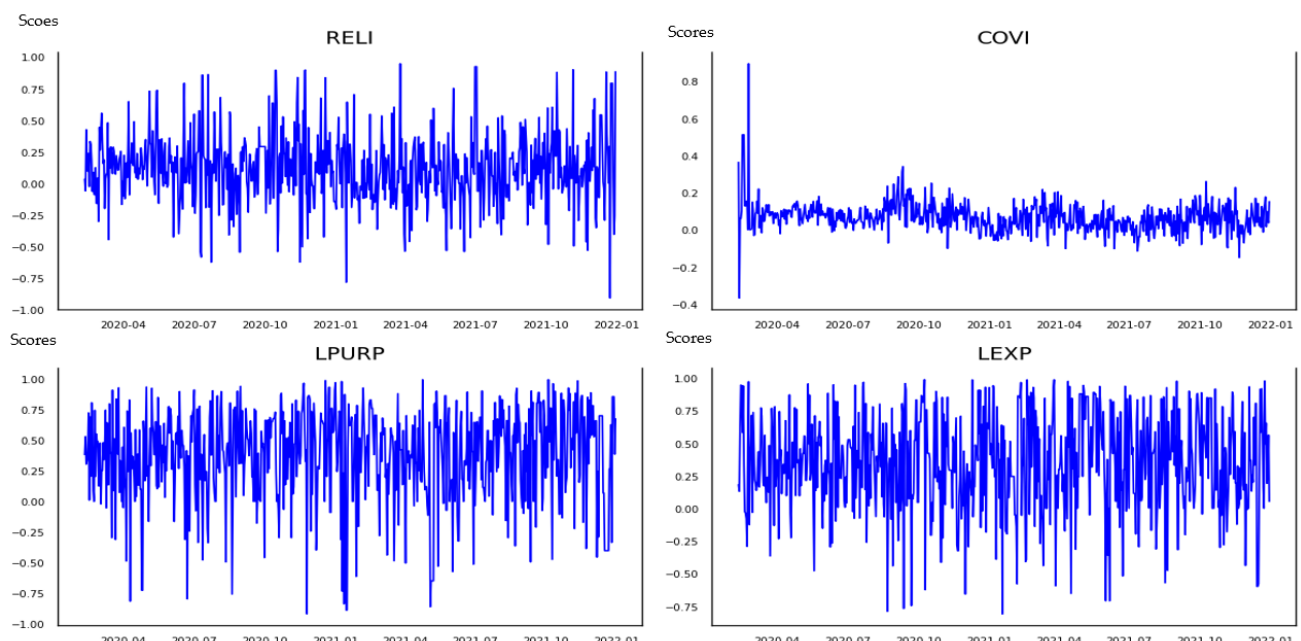
Figure 1. Sentiment scores. Notes: In these plots, the vertical axes represent the sentiment scores and the horizontal axes represent the dates in the sequence of three-month intervals.